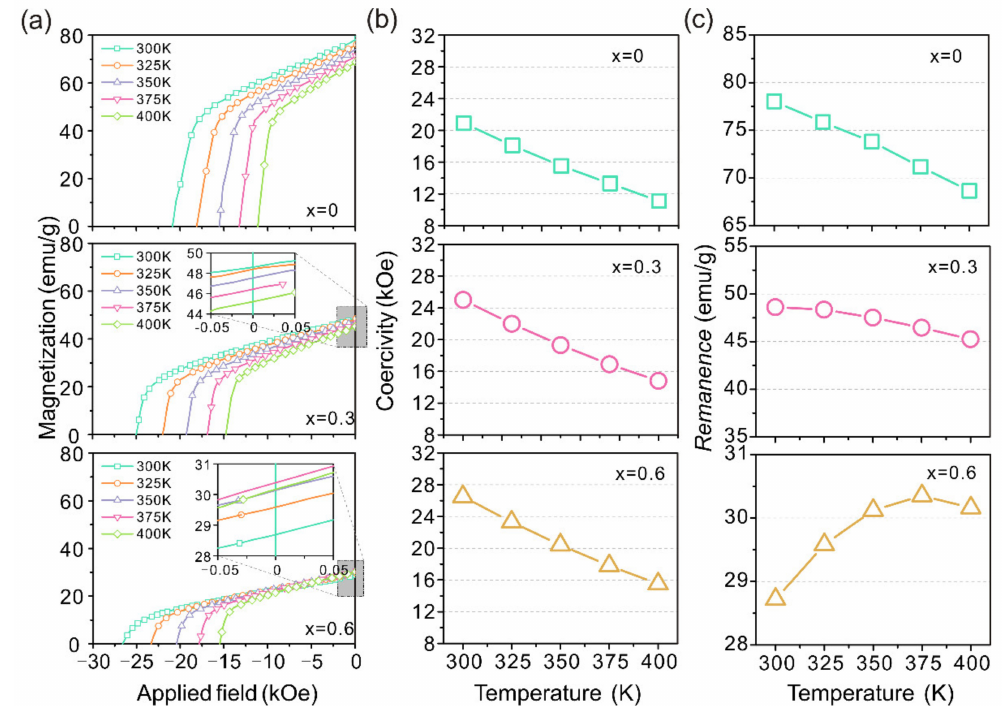
Figure 4. The comparison of temperature coefficients α and β for the Ho-substituted Nd-Fe-B alloys obtained in the current work with a variety of previously reported nanocrystalline melt-spun (ref. from [12,20,21]) and sintered Nd-Fe-B magnets (ref. from [22]) at 300–400 K. The N-, M-, H-, SH-, UH- and EH- stand for commercial sintered magnets with different coercivity ( ≥ 12 kOe, ≥ 14 kOe, ≥ 17 kOe, ≥ 20 kOe, ≥ 25 kOe and ≥ 30 kOe), which is suitable for different operating